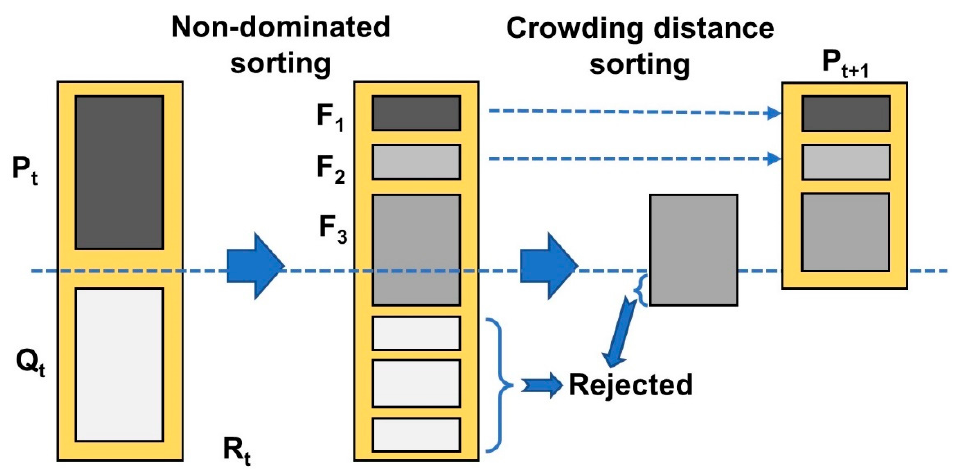
Figure 4. Schematic diagram of NSGA ‐ II algorithm.